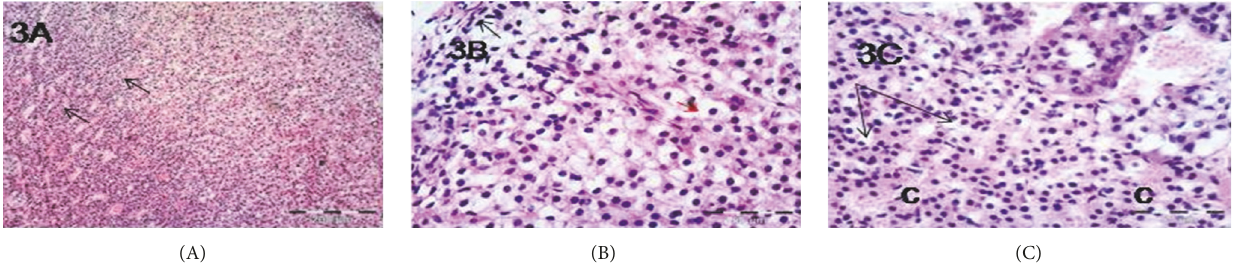
Figure 3: Photomicrographs of the adrenal gland of group III showing (A) marked congested blood capillaries of ZF and ZR (arrows), × 100; (B) cells with marked vacuolated cytoplasm and pyknotic nuclei in ZG (black arrows) and ZF (red arrows), × 400; (C) ZR showing cells with vacuolated cytoplasm and pyknotic nuclei (arrows) and markedly congested capillaries (c), ×